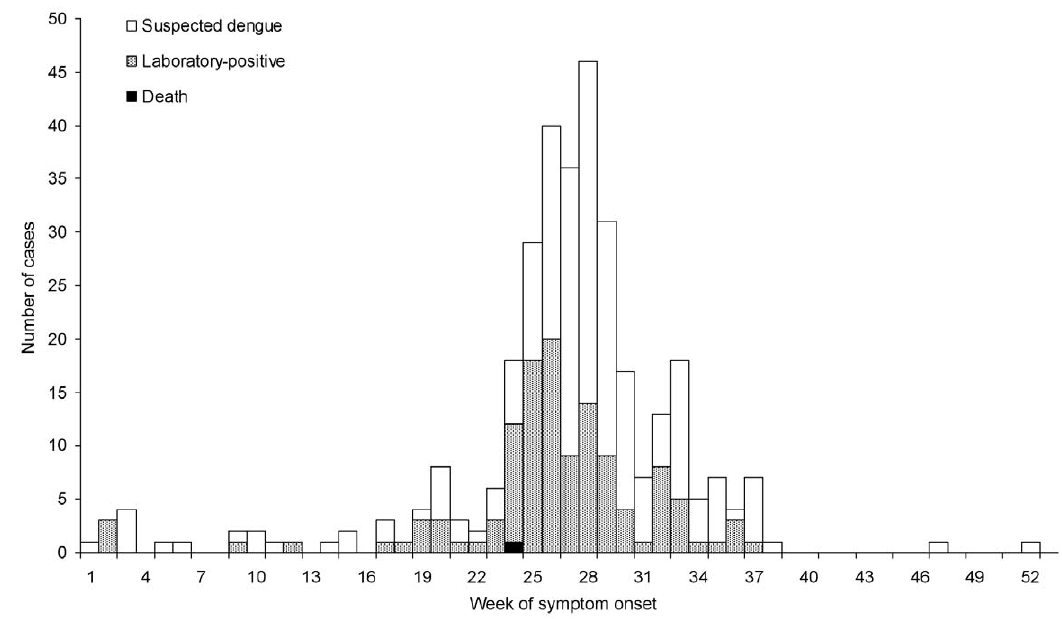
Figure 1. Number of suspected, laboratory-positive, and fatal dengue cases.